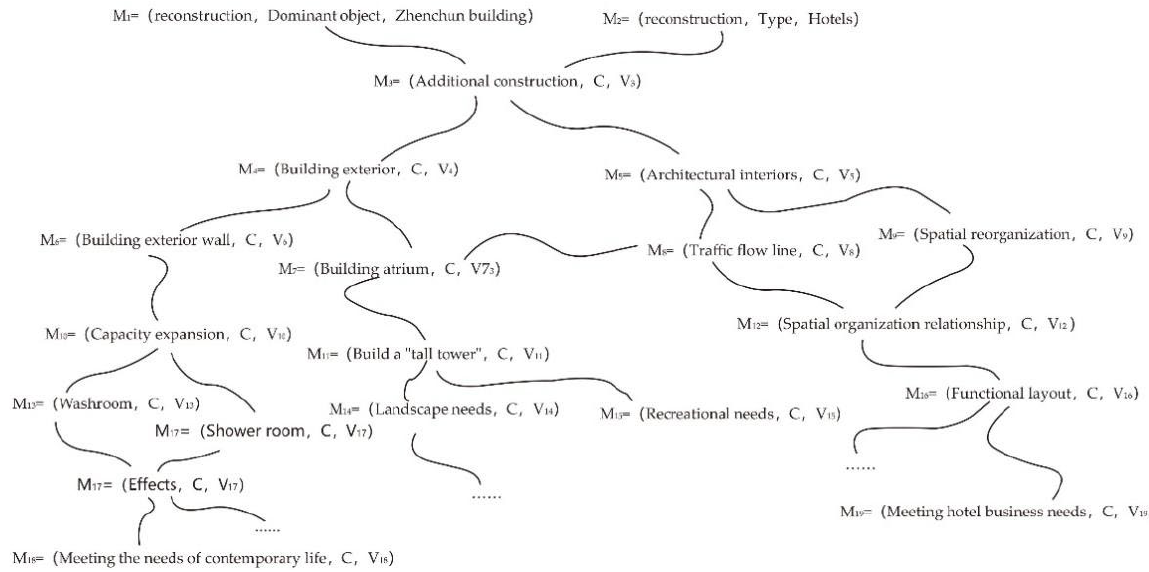
Figure 10. The correlative net analysis of the Zhenchun Building.